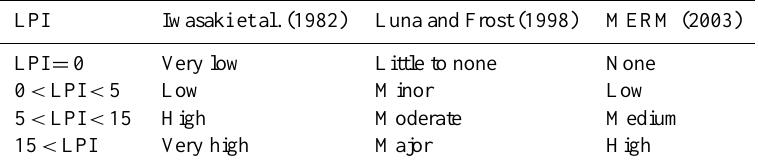
Table 1. The level of liquefaction severity.